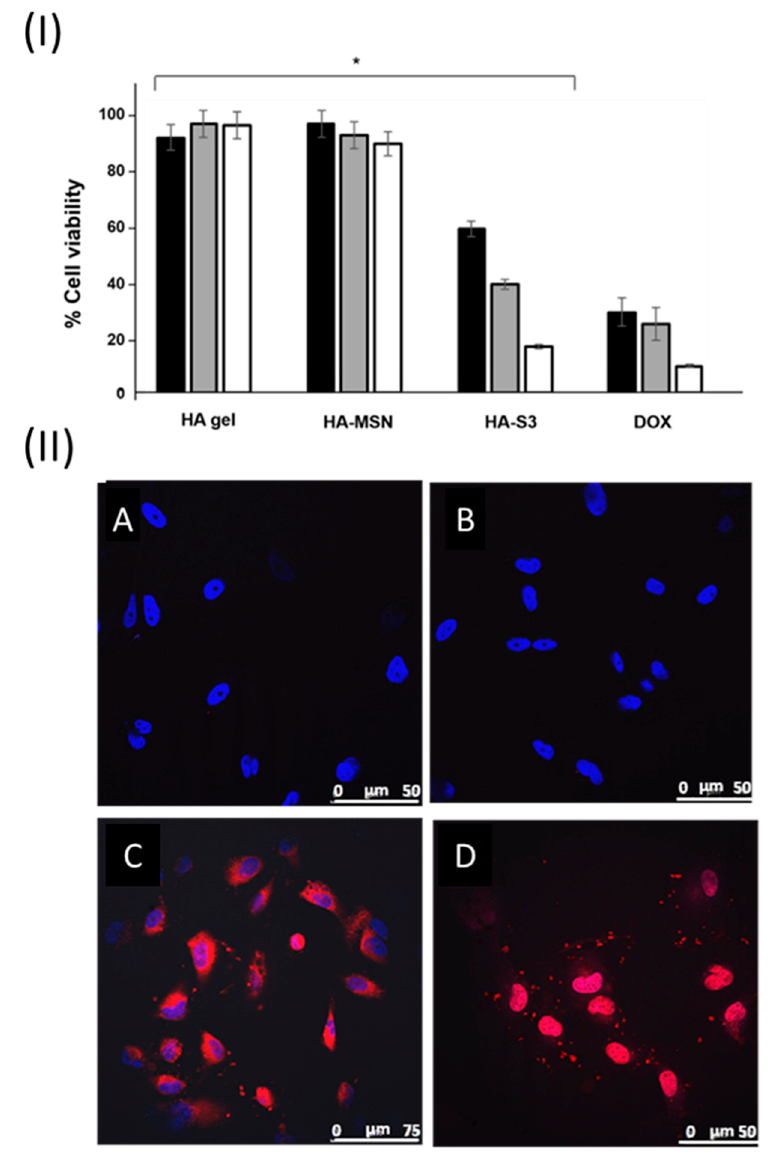
Figure 7. ( I ) Quantification of viable cells as measured by WST-1 assay at 24 h (black), 48 h (grey), and 72 h (white bar). Three independent experiments containing triplicates were performed. Statis- tically signi fi cant di ff erences were observed among the cells treated with HA-S3 when compared to cells treated with the control HA gel or HA-MSN (Student’s t test, * = p < 0.05). The results are ex- pressed as mean ± se. ( II ) Confocal microscope images corresponding to U271 cells treated for 24 h with HA gel ( A ), HA-MSN ( B ), HA-S2 ( C ), and HA-S3 ( D ) loaded with 6 mg mL − 1 of the correspond- ing nanoparticles.